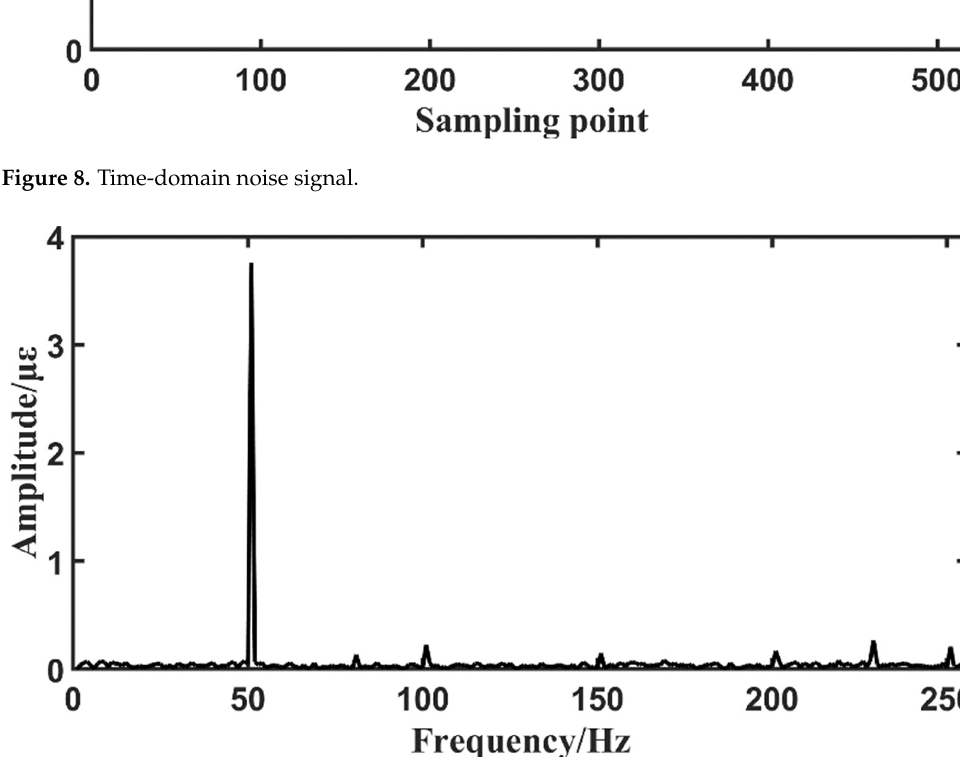
Figure 9. Frequency-domain noise signal.